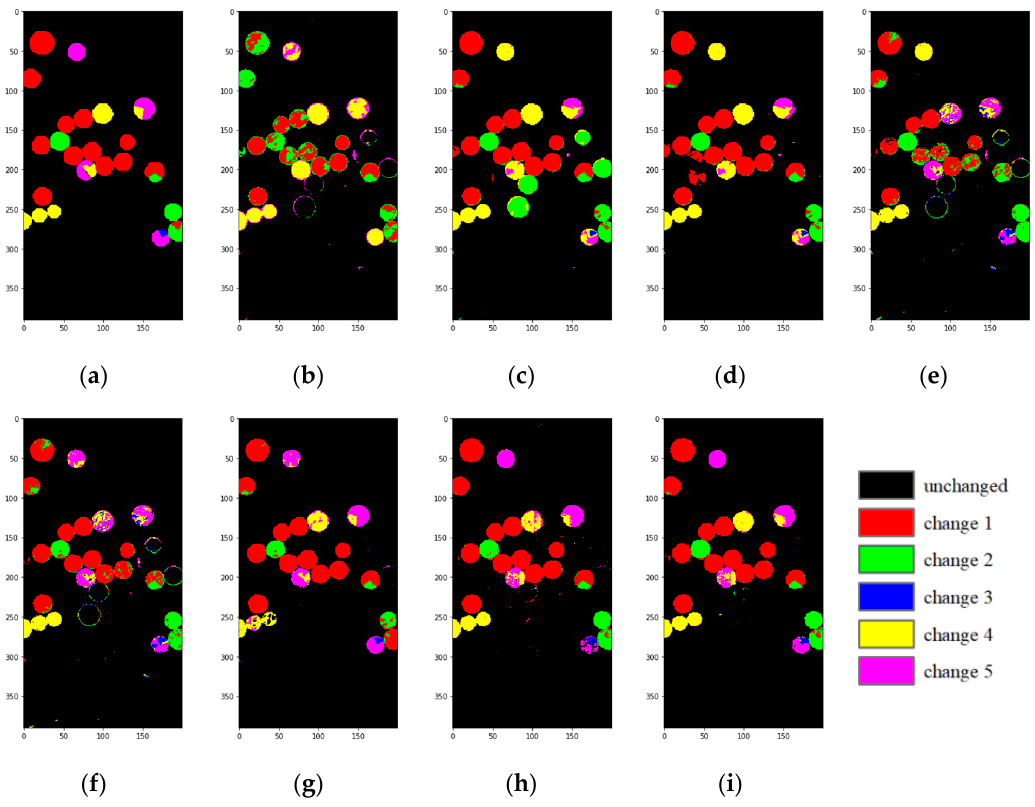
Figure 10. The experimental results of real multitemporal image dataset-2: ( a ) reference image; ( b ) K-means; ( c ) RF; ( d ) SVM; ( e ) SU; ( f ) MSU; ( g ) MSUC; ( h ) SUJMC; ( i ) MSUJMC. Table 4. Accuracy statistics of real HSI